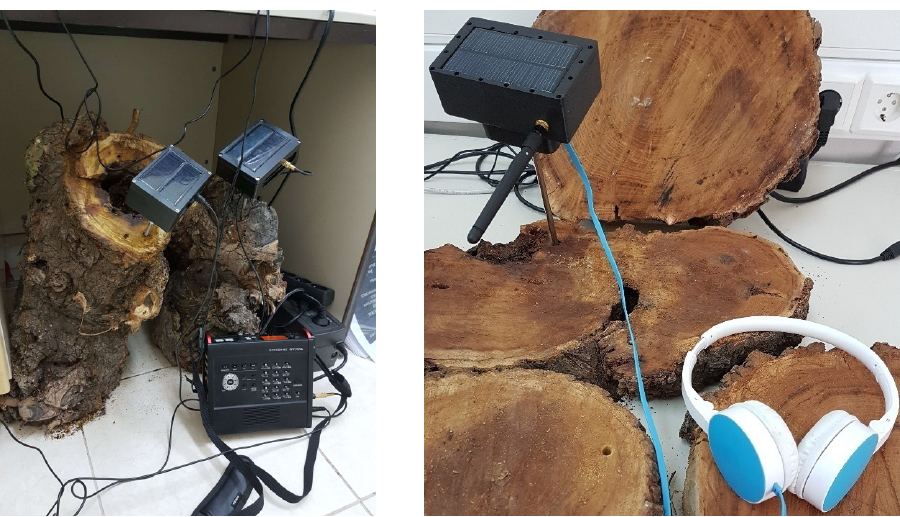
Figure 4. Recording in the lab with a multi-channel recorder.